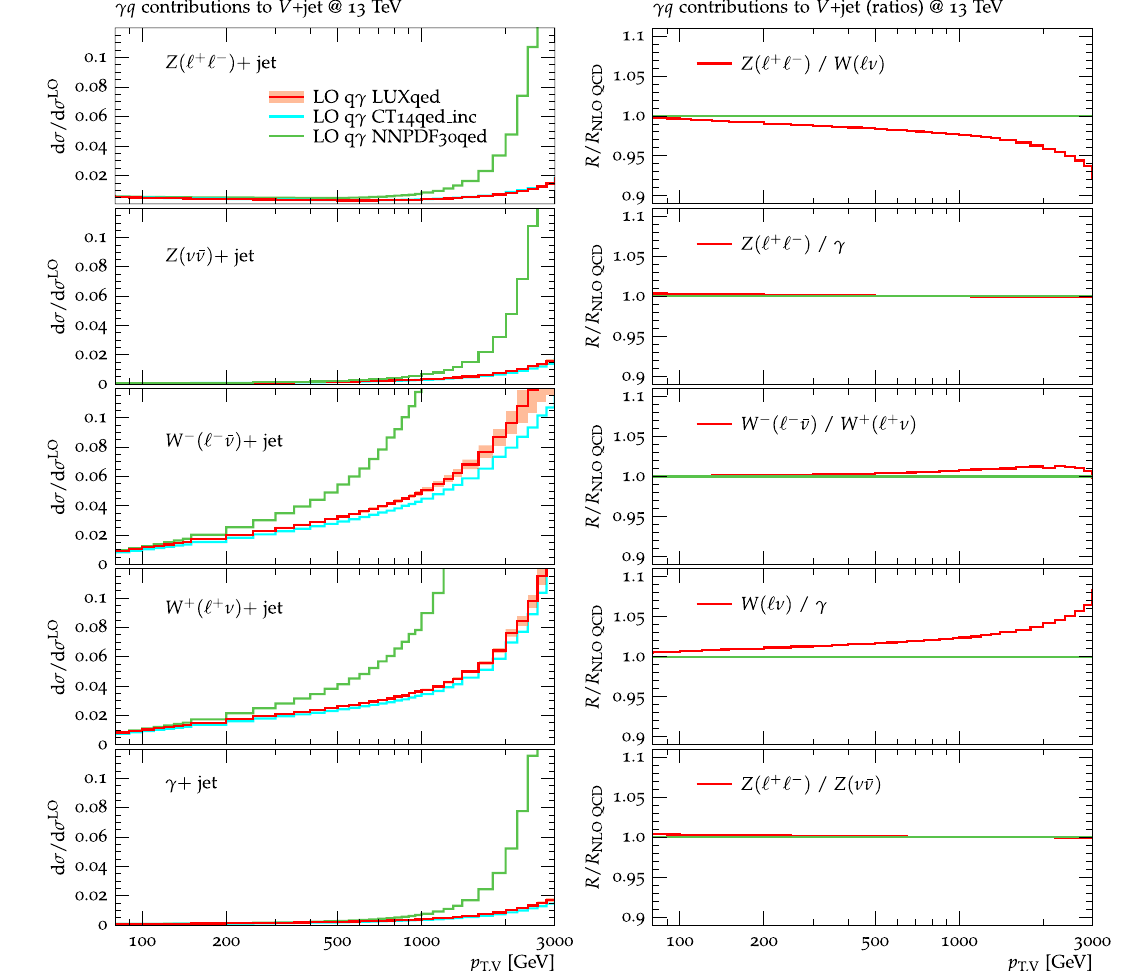
Fig. 12 The left plot illustrates the impact of photon-induced con- tributions at LO, i.e. γ p → V + jet at O (α 2 ) , relative to pp → V + jet at LO QCD for different V + jet processes. Predictions obtained with LUXqed_plus_PDF4LHC15_nnlo_100 , CT14qed_inc and NNPDF30qed PDFs are compared. The error band, shown only for